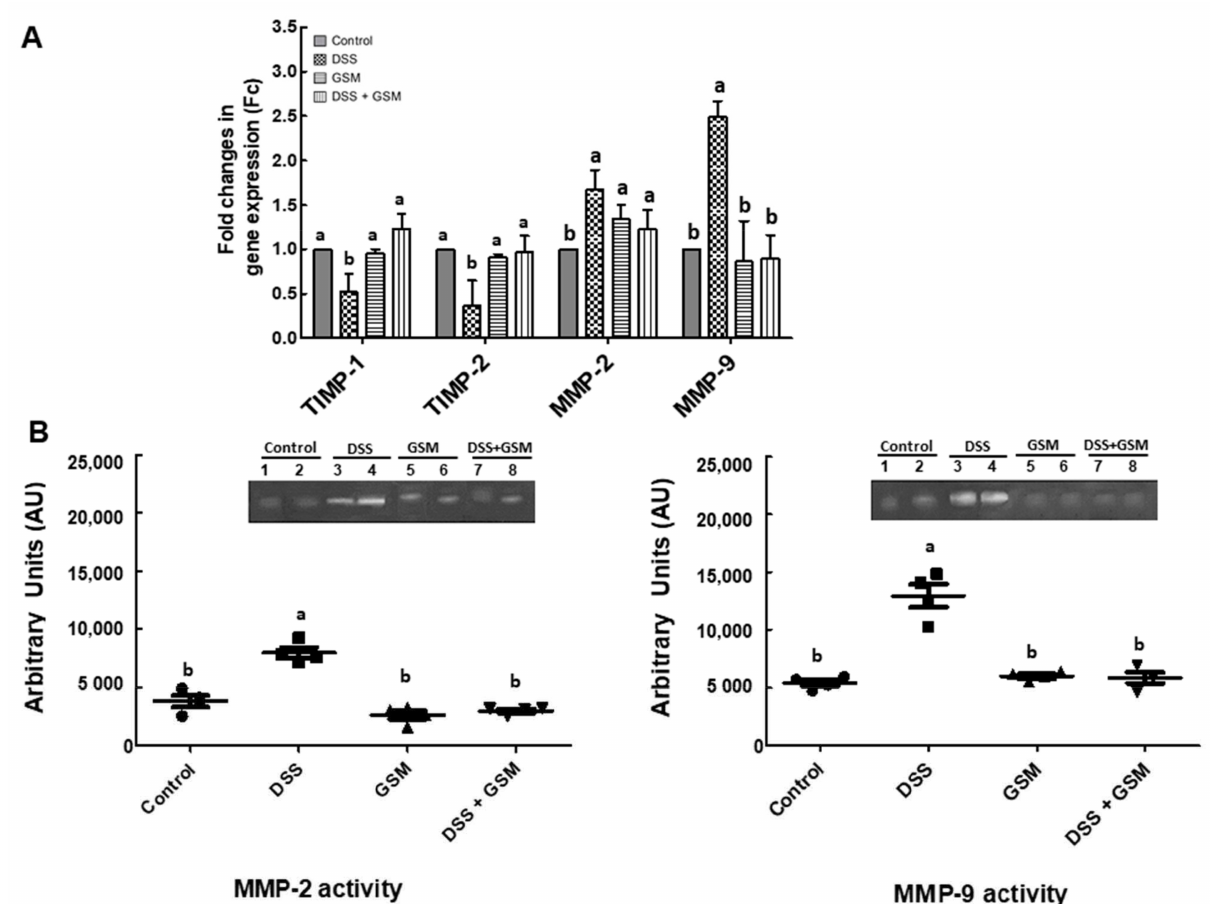
Figure 4. The effects of dietary treatments on the gene expressions of matrix metalloproteinases (MMP) and tissue inhibitors of MMPs (TIMP) ( A ) and on the activity of matrix metalloproteinases (MMPs) ( B ) in the colon of DSS-treated piglets. ( A ) Colon samples were analyzed for the TIMPs/MMPs gene expressions. The expression of target gene was normalized to the geometric mean of two reference genes; the results, expressed as fold changes (Fc) are presented as mean ± SEM. Values are the means from two independent replicates of colon samples (n = 5/group), with their standard errors represented by vertical bars. a,b Groups with unlike superscript letters were significantly different ( p < 0.05; one-way ANOVA followed by Fisher test). ( B ) Colon lysates were resolved on SDS–PAGE gelatin zymography as described in Materials and Methods. Results were expressed as arbitrary units (A.U.) and are represented as means ± SEM. a,b Groups with unlike superscript letters were significantly different ( p < 0.05; one-way ANOVA followed by Fisher